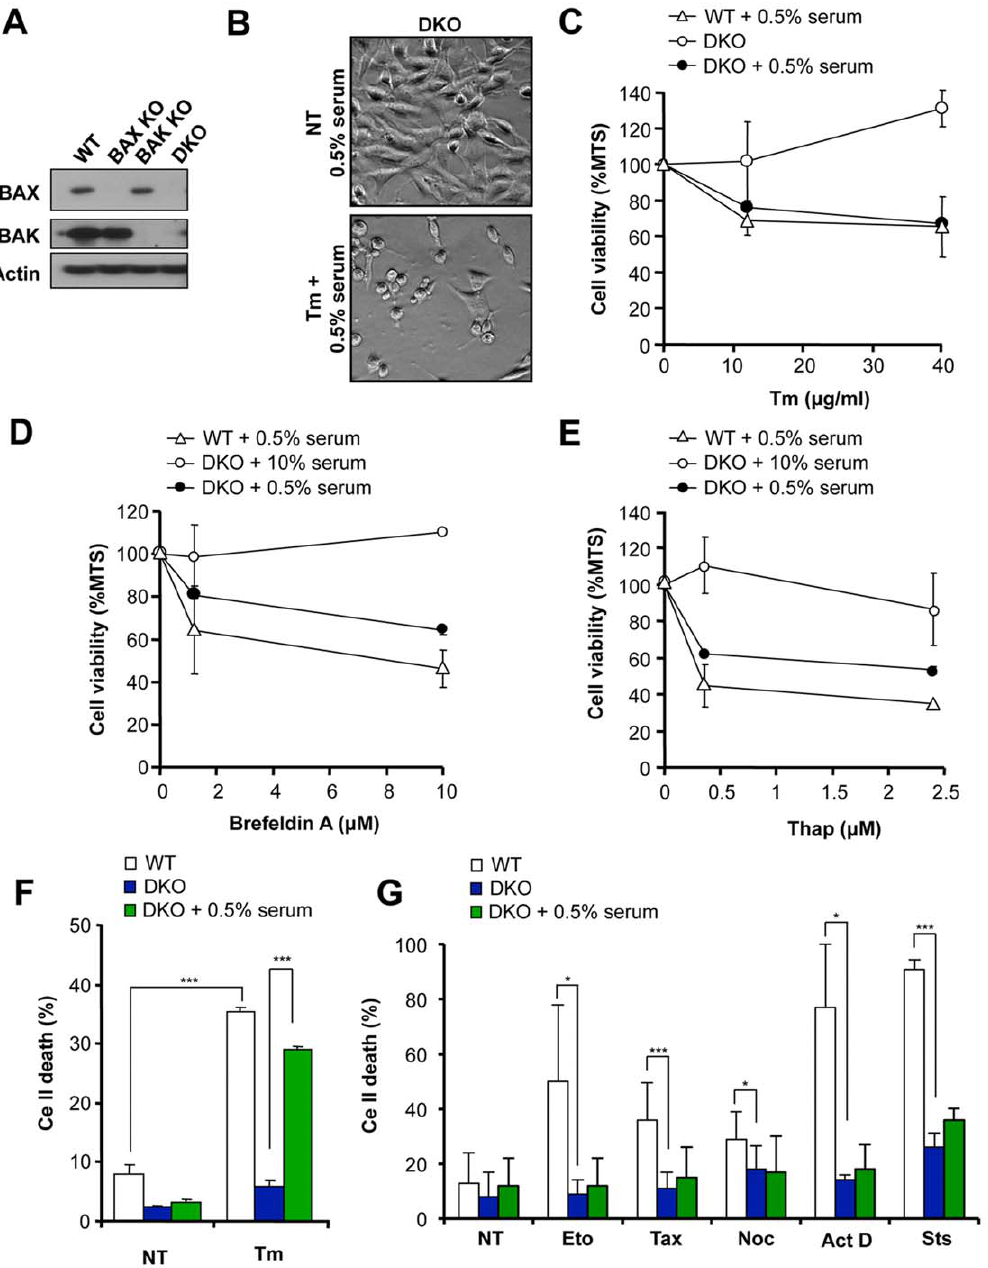
Figure 1. Serum withdrawal recovers the susceptibility of BAX and BAK DKO cells to ER stress-induced cell death. ( A ) Expression levels of BAX and BAK were determined in murine embryonic fibroblast from wild type (WT), BAX or BAK single knockout (KO) or BAX and BAK DKO (DKO) cells by Western blot. As a loading control actin levels was determined. ( B ) Phase contrast images of BAX/BAK DKO cells treated or not (NT) with 10 m g/ml Tm for 16 h in cells pre-exposed for 2 h to cell culture media containing 0.5% serum. ( C ) BAX and BAK DKO MEFs were treated with indicated concentrations of Tm, ( D ) Brefeldin A or ( E ) Thap in cells grown in regular cell culture media or pre-treated in media containing 0.5% serum for 2 h. WT cells grown in media containing 0.5% serum were monitored as control (see additional controls in Figure S1). After 24 h of treatment, cell viability was analyzed with the MTS assay. Mean and standard deviations are presented of triplicates of a representative experiment. ( F ) BAX and BAK DKO cells were pre-incubated for 2 h in cell culture media containing 0.5% serum or grown with regular cell culture media (10% serum), and then treated with a panel of different intrinsic death stimuli, including 10 m g/ml Tm. Untreated cells (NT) were used as control. After 24 h of treatment cell death was monitored by propidium iodide (PI) staining and FACS analysis. Results represent average and standard deviation of six independent experiments. Student’s T-test was used to analyze statistical significance between cells treated with Tm in the presence of 10% or 0.5% serum. (***: p , 0.001). ( G ) Alternatively, cells were analyzed as described in F and treated with 20 m M etoposide (Eto), 1 m M taxol (Tax), 10 m M nocodazole (Noc), 10 m g/ml actinomycin D (Act D) or 0.1 m M staurosporine (Sts). Results represent average and standard deviation of 4 independent experiments. Student’s T-test was used to analyze statistical significance between cells treated with these drugs in the presence of 10% or 5% of serum (*: p , 0.05; ***: p , 0.001).